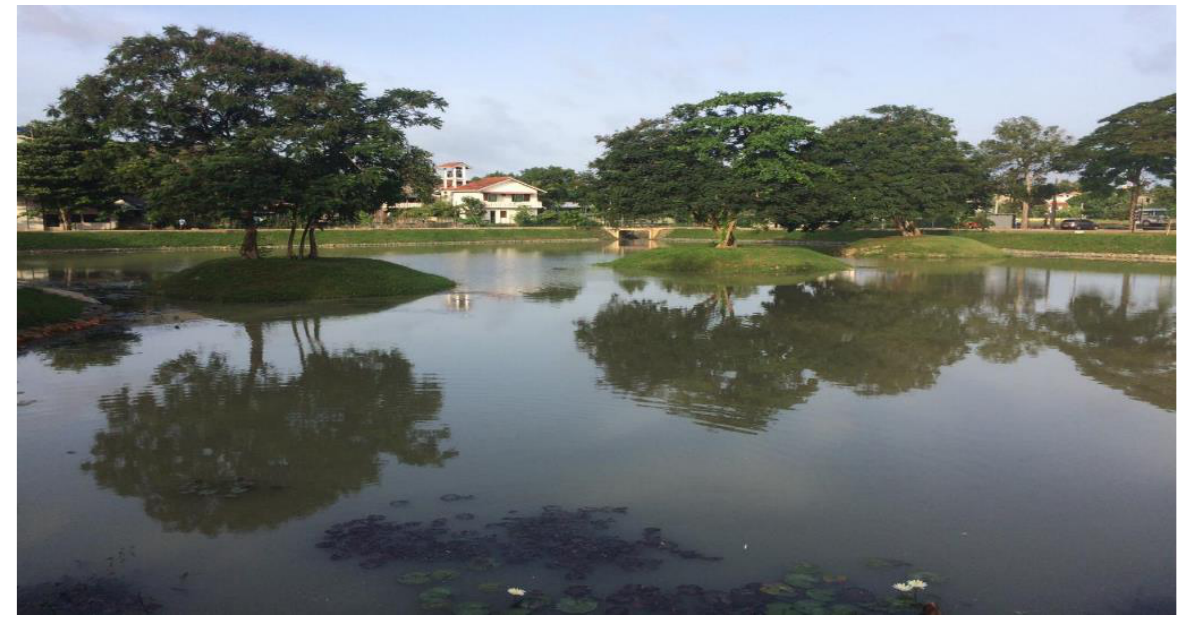
Figure 10. A restored wetland as a part of city-wide wetland network (Field survey, 2021).